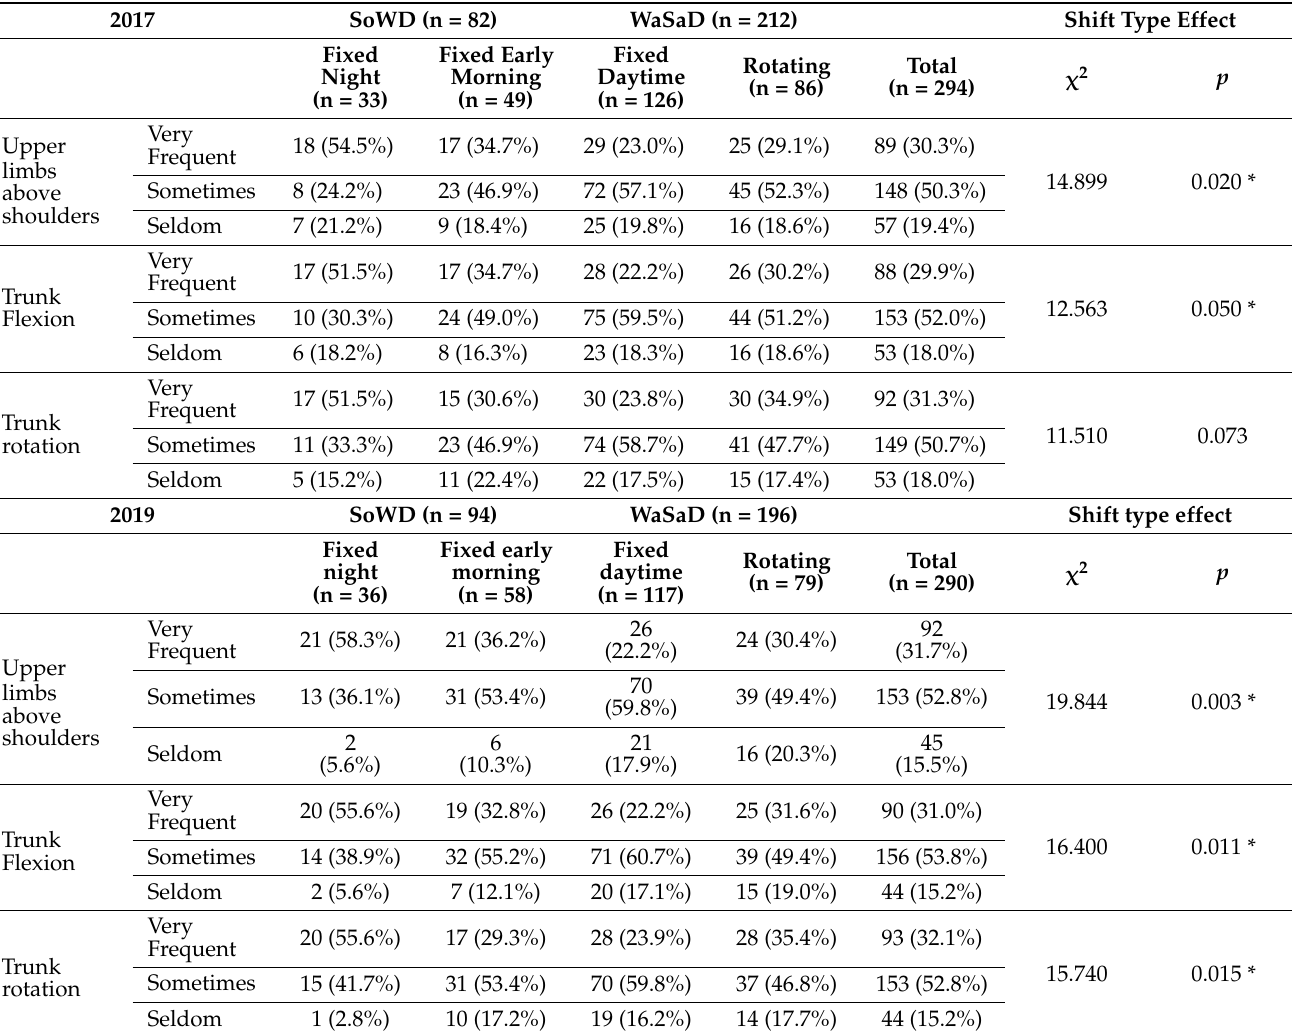
Table 3. Perception of upper limbs (above shoulders) and trunk (flexion and rotation) (Frequency (%)) in 2017 and 2019 by shift type and results of Chi-square test for homogeneity comparing shift